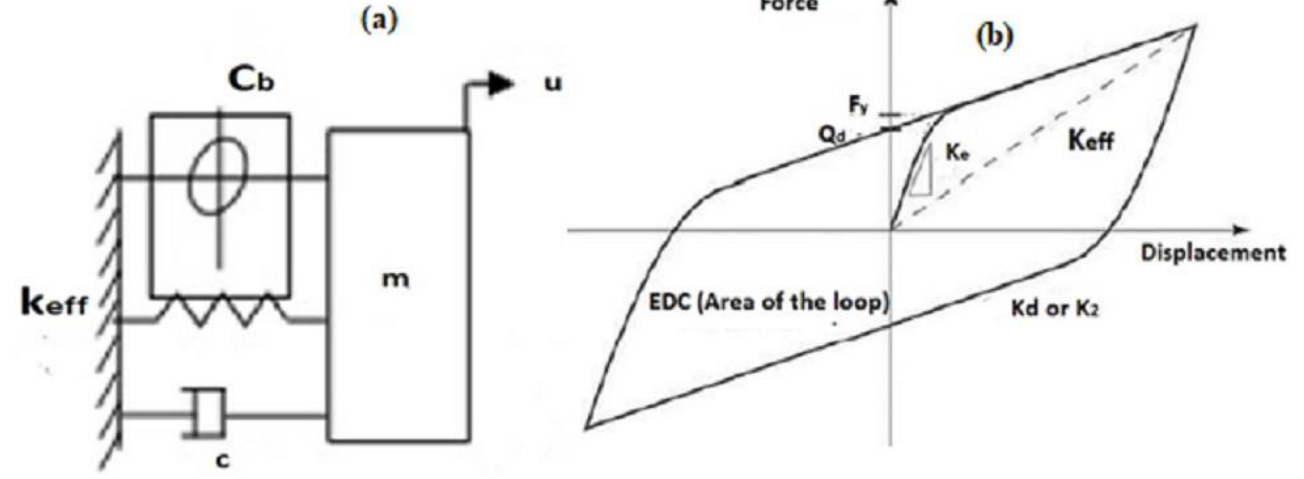
Figure 4. Lead rubber bearing ( a ) analytical model, ( b ) force-deformation behavior .